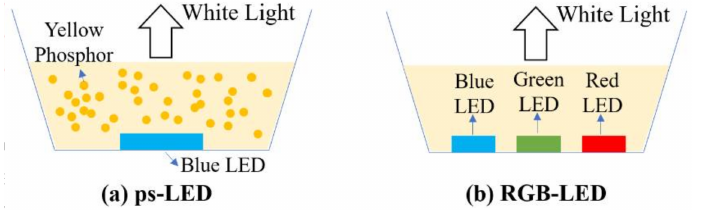
Figure 3. Schematic diagrams of ps-LED ( a ) and RGB LED ( b